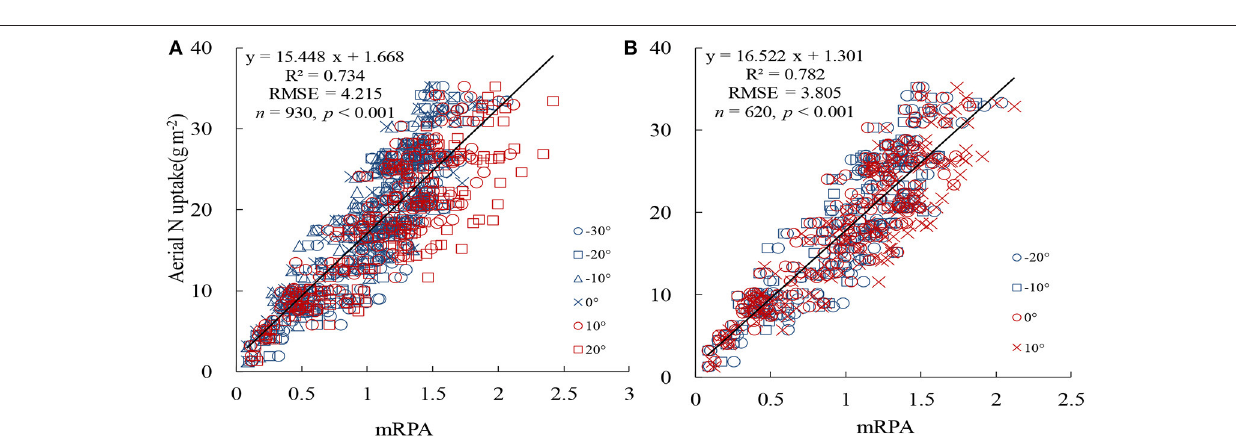
the normalized area over reflectance curve index (NAOC) and this index showed a linear relation with chlorophyll